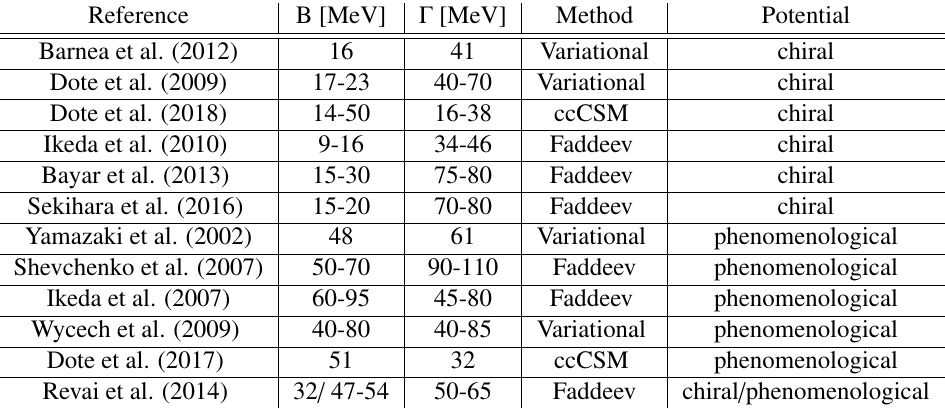
Table 1. Binding energy and width of K − pp for di ff erent chiral and phenomenological calculations using variational, Faddeev or ccCSM + Feshbach methods. Table modified from Table 2 of Ref.